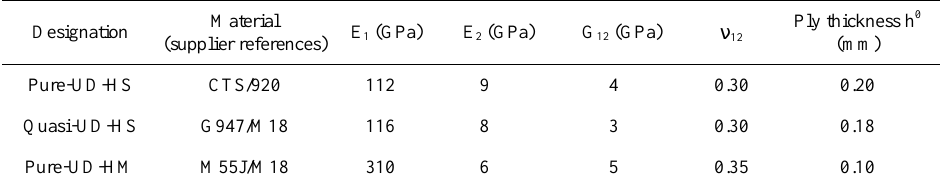
Table 1. Materials elastic